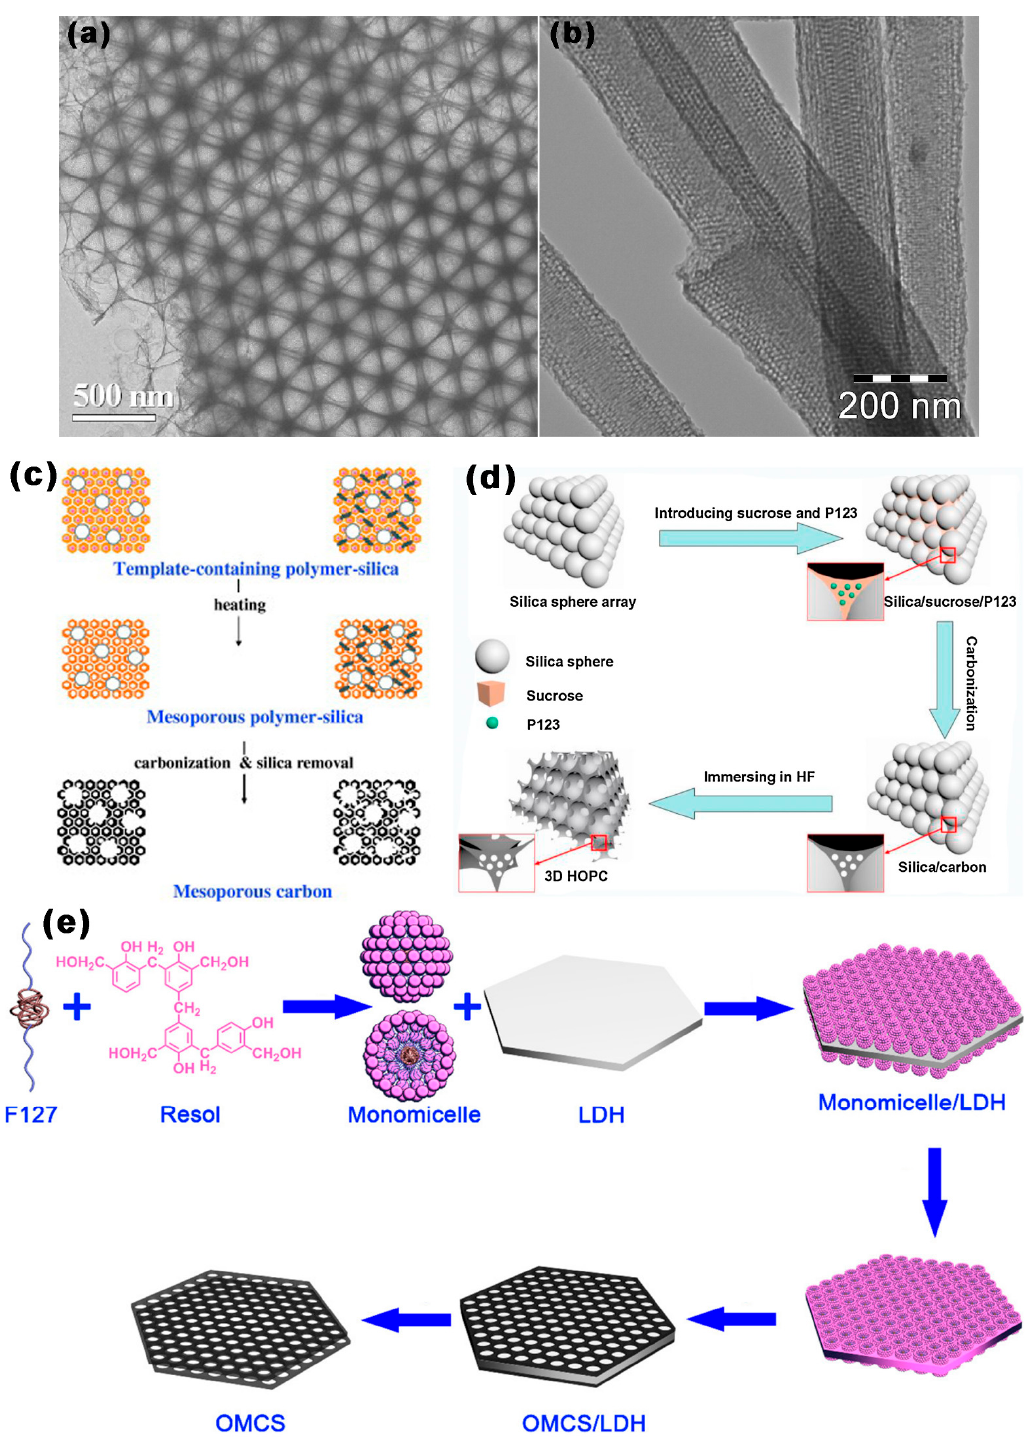
Figure 5. MCBM prepared by the hard templates method. Schematic diagram and TEM images of MCBM based on soft/hard templates: ( a ) TEM image of ordered macro-/mesoporous carbons with Silica colloidal crystals and PEO–PPO–PEO as hard/soft template [61]. ( b ) TEM image of mesoporous carbon nanofibers with AAO membrane and F127 as hard/soft template [74]. ( c ) SiO 2 and PEO–PPO–PEO for mesoporous carbon [71]. ( d ) SiO 2 nano-array and P123 for 3D mesoporous carbons [75]. ( e ) LDH and F127 for ordered mesoporous carbon sheets